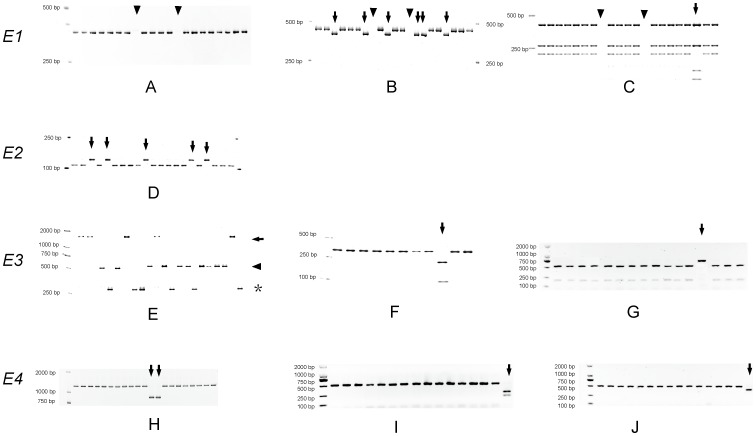
Genotyping methods for E1 to E4 loci.A–C: Genotyping of the E1 gene. Fragment was amplified by primer pair of TI-Fw and TI-Rv (A), subsequently subjected to TaqI digestion (B) and HinfI (C). The triangle represents the e1-nl type (lacking of fragment). The arrows in B and in C are representing e1-as and e1-fs genotypes, respectively. D: Genotyping of the E2 gene, fragment was amplified with primer pair of SoyGI_dCAP_Dra_fw and SoyGI_dCAP_Dra_rv, after digestion of DraI, the e2 was cut into two fragments, while E2 genotype remained uncut (arrows). E–G: Genotyping of the E3 gene. E: bands with three sizes were generated using the mixed primers. Band specific for E3-Mi and e3-tr were indicated by arrow and star, respectively. A 557 bp fragment (triangle) could be amplified either for E3-Ha or e3-Mo genotypes. F: PCR product yielded from primer pair E3_08094FW and E3_08417RV were digested with MseI. The E3-Ha genotype remained uncut, while e3-Mo allele (arrow) could be cut into 223 bp and 101 bp. G: specific determination of E3-fs type (arrow). CAPE primer pair E3-fsFW/E3-fsRV, restriction enzyme: AleI. H-J: Genotyping of the E4 gene. H: Using three mixed primers, a 837 fragment was specifically amplified from the E4 allele (arrow). I: CAPE primer pair e4-kam specific for e4-kam gene (arrow), enzyme AflII. J: CAPE primer pair e4-kes specific for e4-kes genotype (arrow), enzyme BspHI.